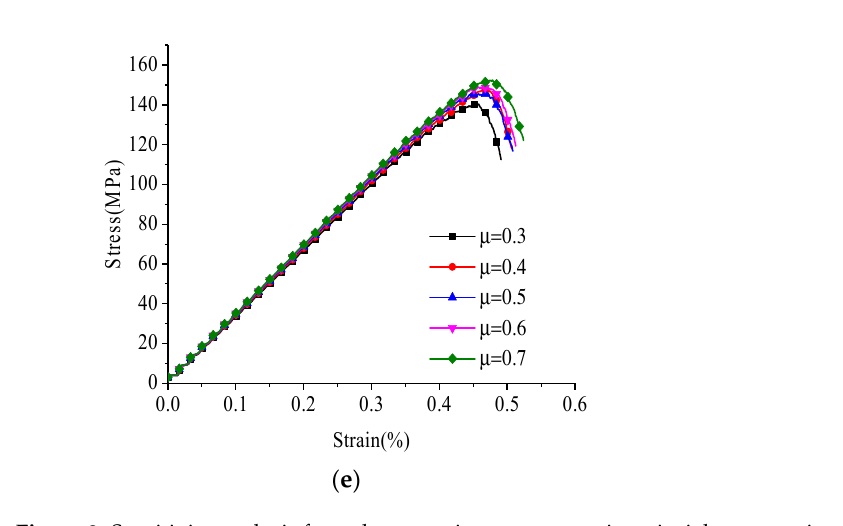
Figure 9. Sensitivity analysis for unknown microparameters in uniaxial compression test. ( a ) Parameter E c ; ( b ) Parameter K n / K s ; ( c ) Parameter σ c ; ( d ) Parameter τ c ; and ( e ) Parameter µ .